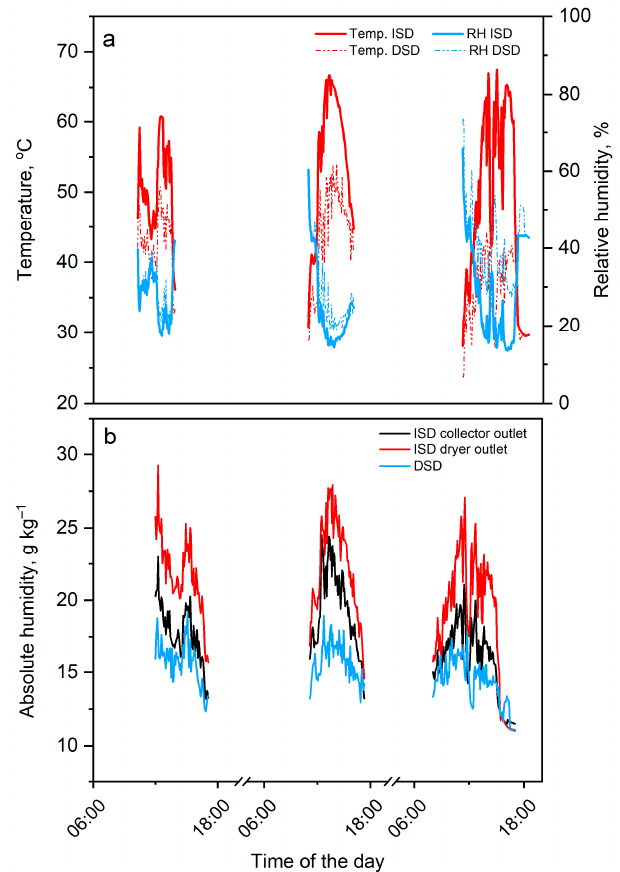
Figure 2. Temperature and relative humidity ( a ) and absolute humidity ( b ) in the inflatable solar dryer (ISD) and for direct sun drying (DSD), shown exemplarily for batch 1 of the drying experi- ment.